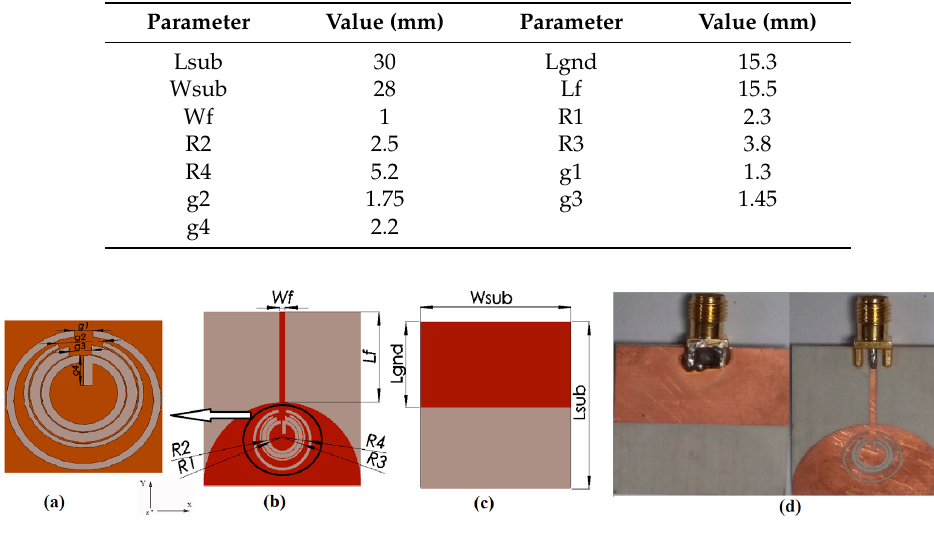
Figure 1. Geometry of the proposed antenna, ( a ) Magnified view of the CSRR, ( b ) Front View, ( c ) Rear-View, and ( d ) Realized prototype.